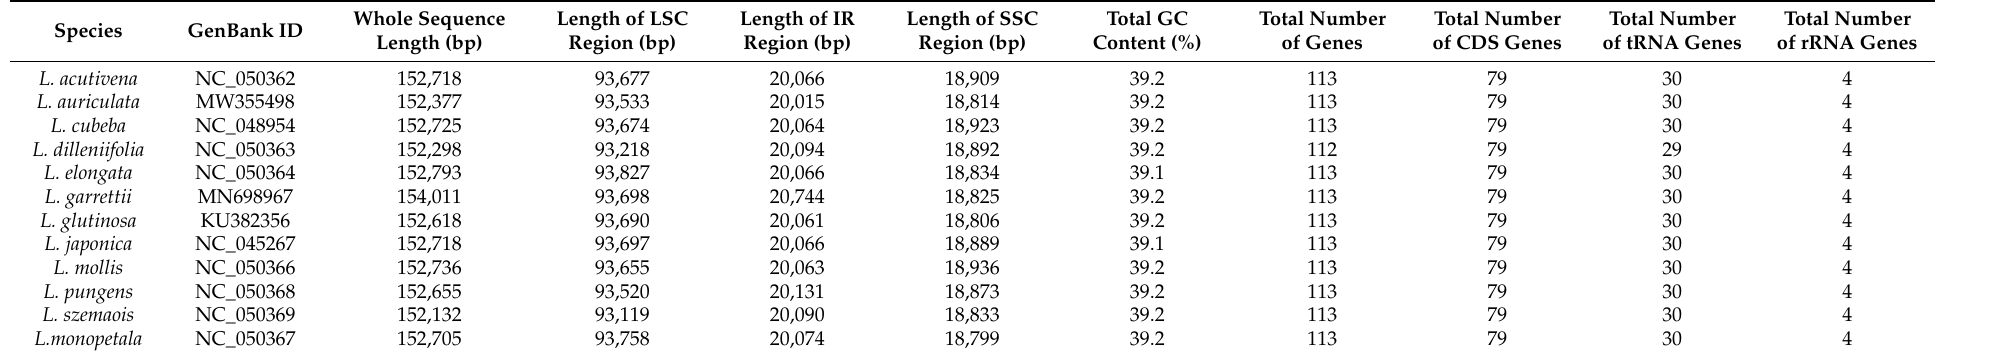
Table 1. Comparison of complete plastid genomes of 12 Litsea species.